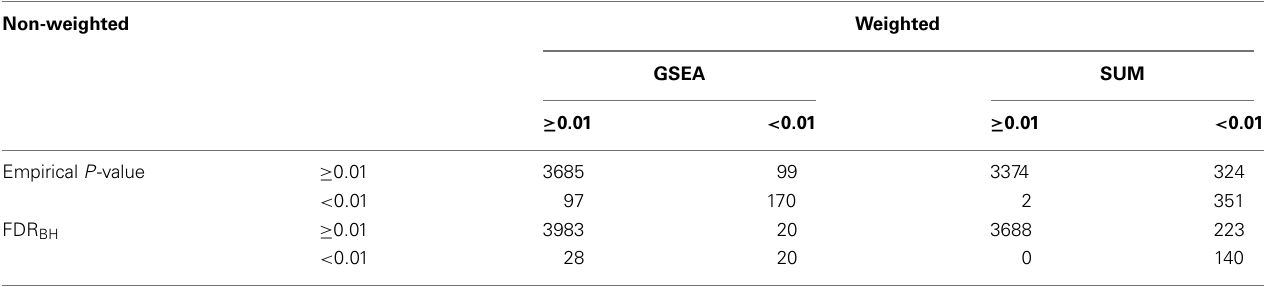
Empirical P -value < 0.01